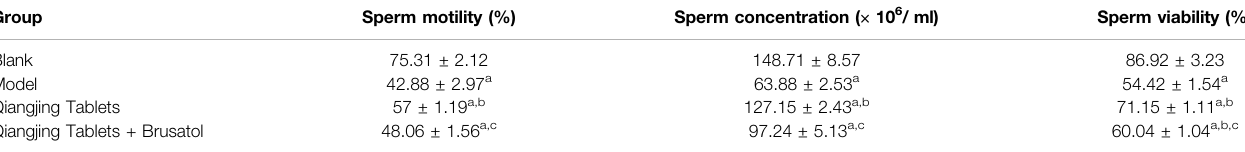
TABLE 2 | Sperm motility, sperm concentration, and sperm viability of different groups after the treatment of Qiangjing Tablets. Group